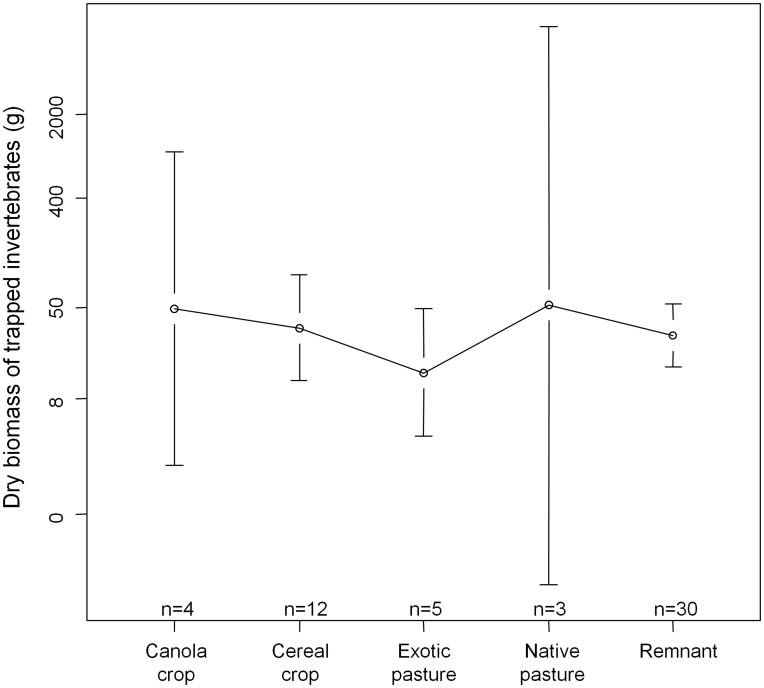
PCA biplot with loadings of the five vegetation measures on habitat components 1 and 2.Habitat component 1 separates sites according to condition, ranging from ‘intact’ (more negative scores) to ‘degraded’ (more positive scores) Habitat component 2 related to site structure: ‘shrub/grassland’ in the negative values to ‘grazed/cropped woodland’ in the positive values. Survey points are plotted according to the land use class that they occur within.